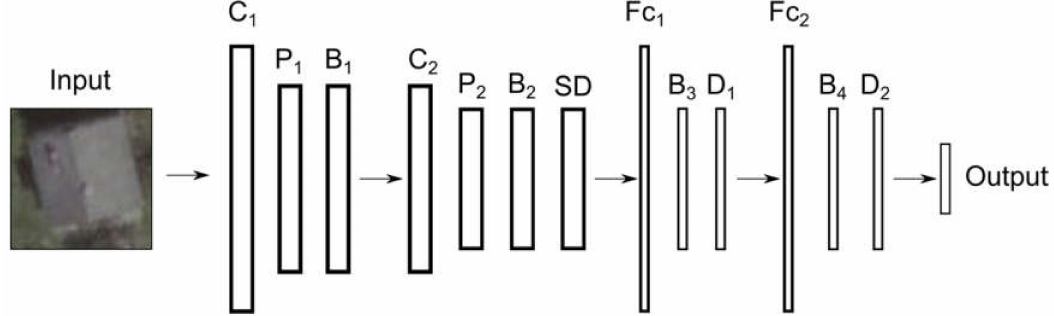
Figure 4. Convolutional neural network used in this study. C—convolutional layers; P—pooling layers; B—batch normalization layers; SD—spatial dropout layer; D—dropout layers.